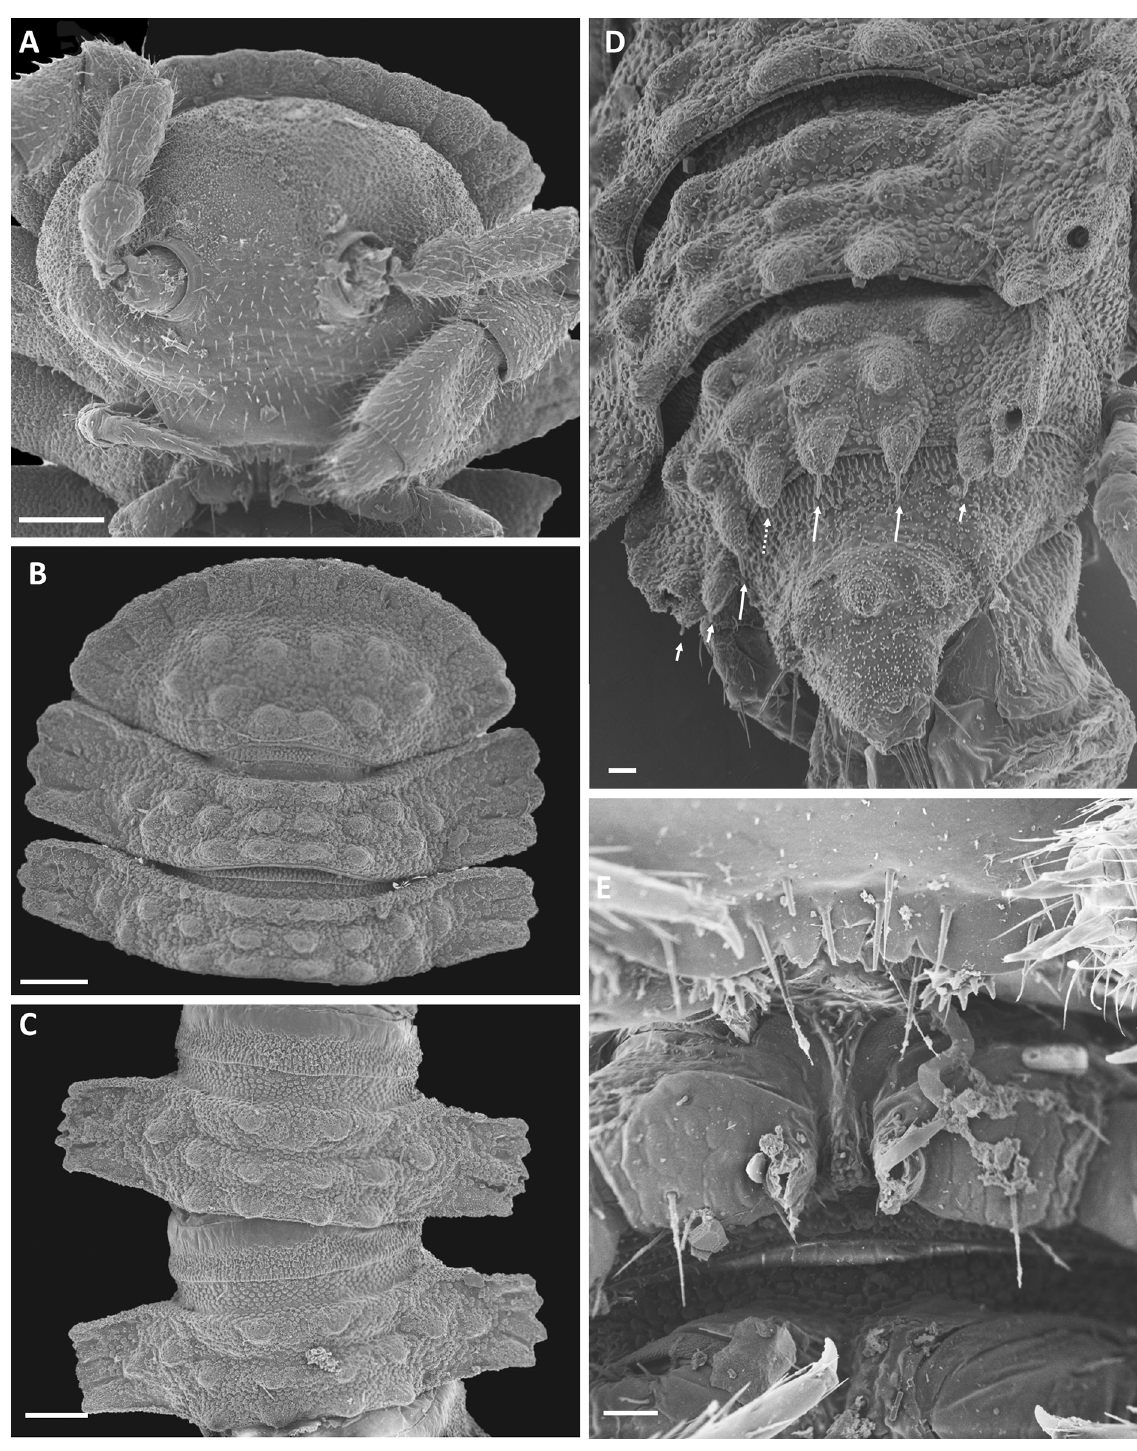
Fig. 10. Cryptocorypha exovo sp. nov., holotype (NHMD 621840), ♂. A . Head, frontal view. B . Collum and rings 2–3, dorsal view. C . Rings 2–3, dorsal view. D . Rings 16 (part), 17, 18 (apodous) and telson, oblique dorsal view, showing setae (long arrows) and a probably abraded seta (long stippled arrow) on posterior row of tubercles on apodous ring, and setae (short arrows) on paranota of apodous ring. E . Labrum and second coxae. Scale bars: A–C = 0.1 mm; D–E = 0.02